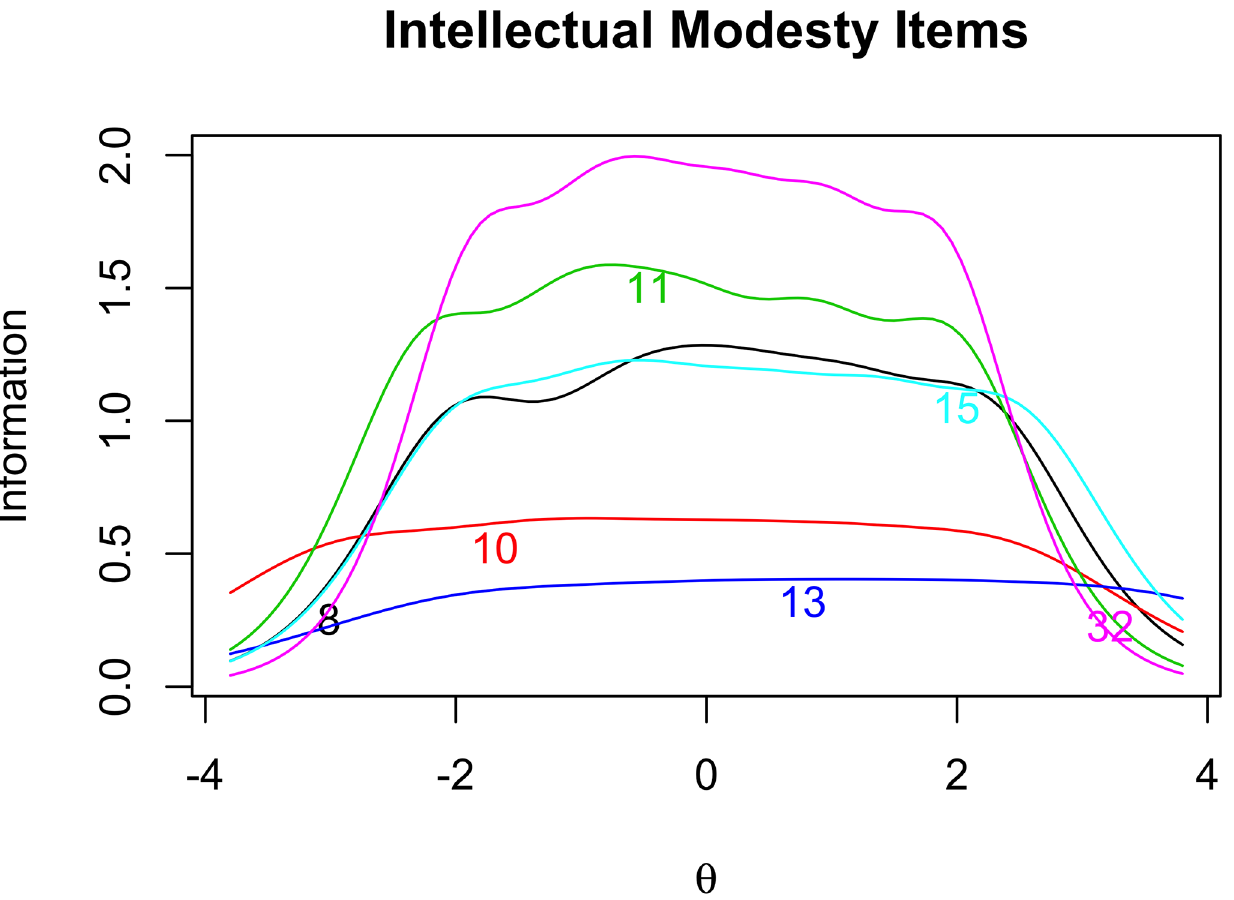
Fig 2. Intellectual modesty item response analysis. Item information curves for IntellectualModesty